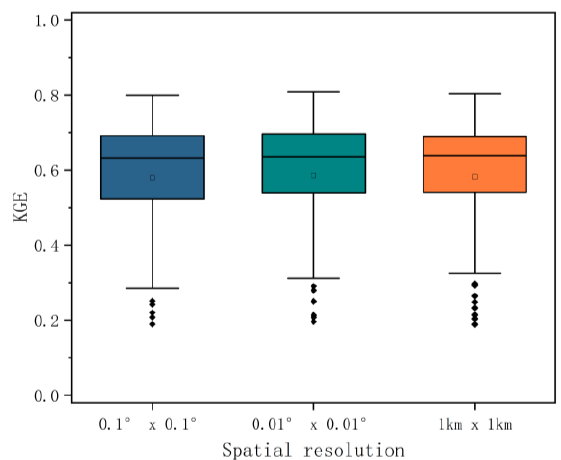
Figure 8. KGE values for the fused precipitation product calculated at three spatial resolutions (0.1°, 0.01°, and 1 km).